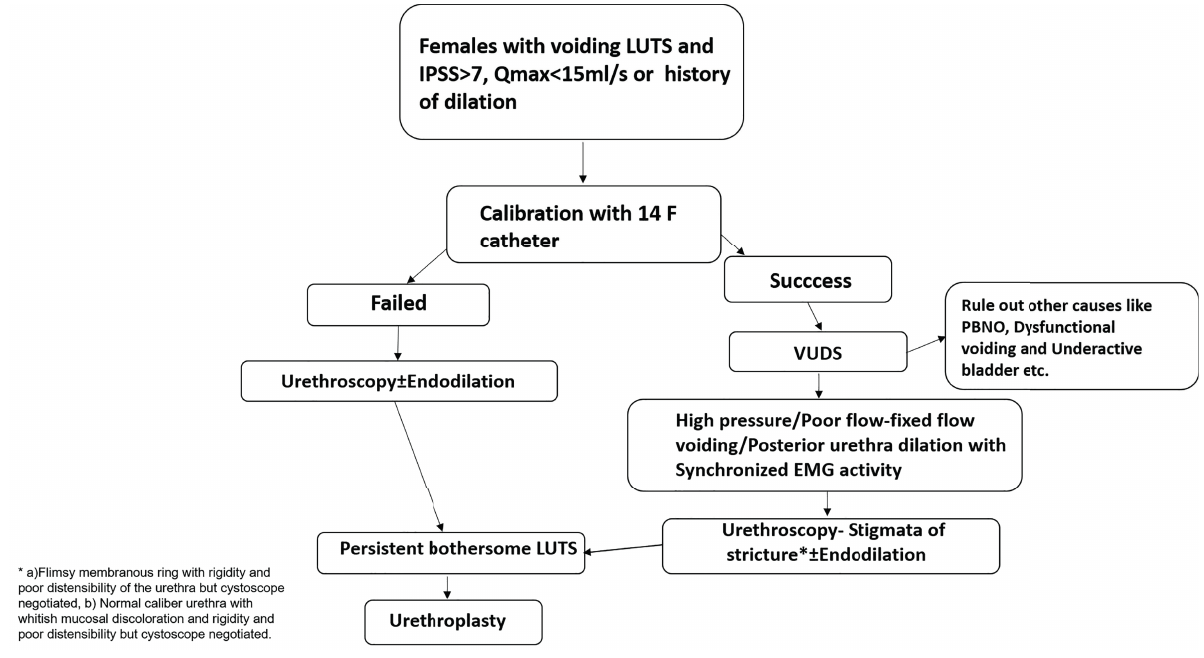
Figure-1 - Management protocol for patients suspected with